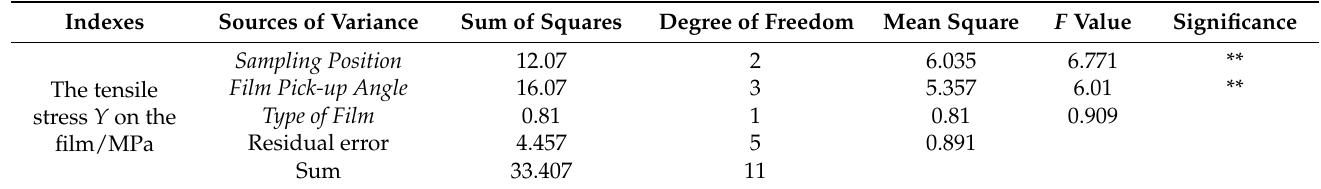
Table 5. Variance